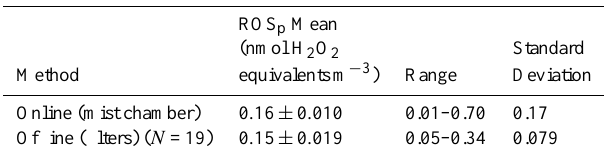
Table 3. Comparison of online and offline ROS p